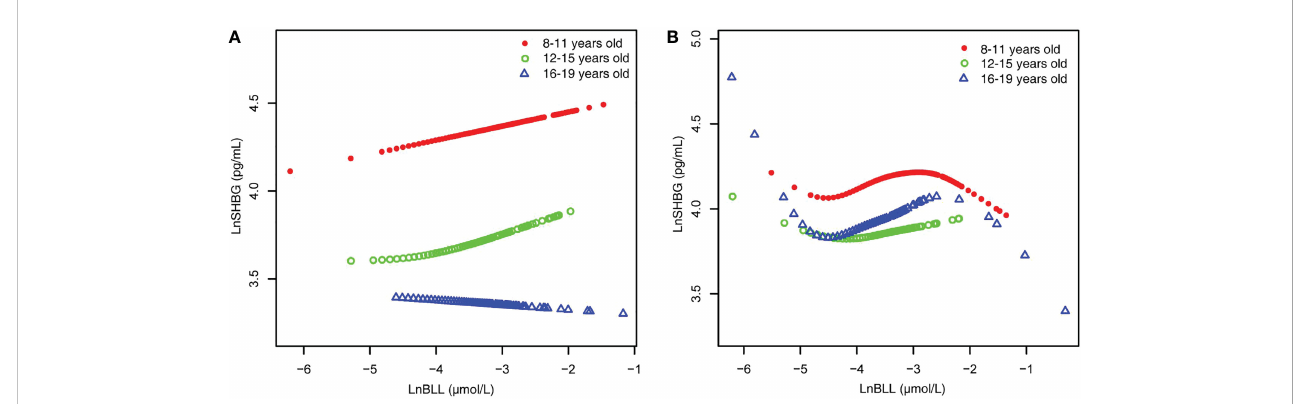
FIGURE 4 BLL and SHBG dose – response relationship, strati fi ed by age. (A) male. (B) female. Adjusted for ratio of family income to poverty; total energy, Ln(iron) and Ln(zinc) intake on the fi rst day; fi sh eaten during the past 30 days, moderate recreational activities, body mass index, hematocrit, serum continine, Ln (serum albumin), Ln(serum copper) and Ln(serum zinc). BLL, Blood lead levels; SHBG, Sex hormone-binding globulin.